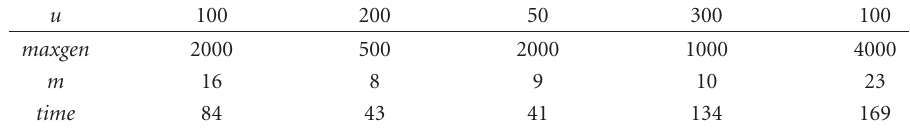
Table 4.6. Search results of 5 di ff erent parameter values for a 16-dimensional set by our approach. u 100 200 50 300 100